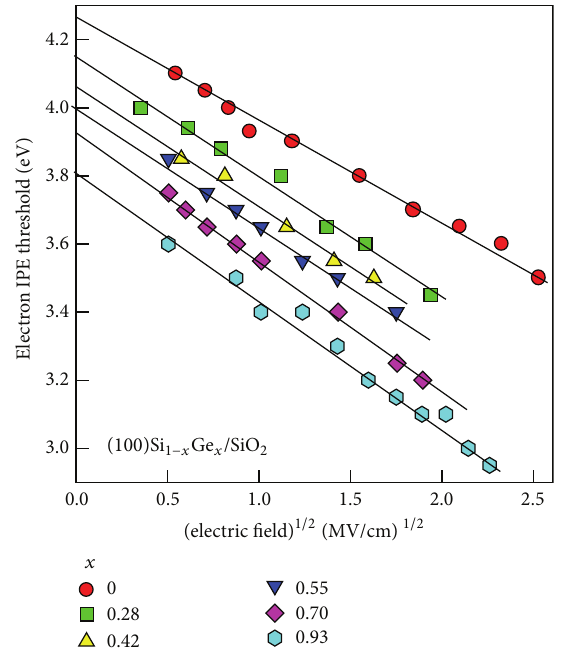
Figure 20: Schottky plot of the electron IPE spectral threshold from the VB of Si 1−𝑥 Ge 𝑥 layers with different Ge content into the CB of thermal SiO 2 . Lines illustrate linear fits used to determine the zero- field barrier value.